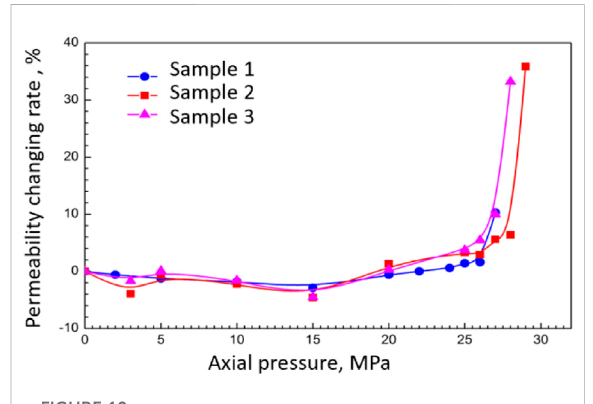
FIGURE 10 Fracture generation curves in water-saturated cores.